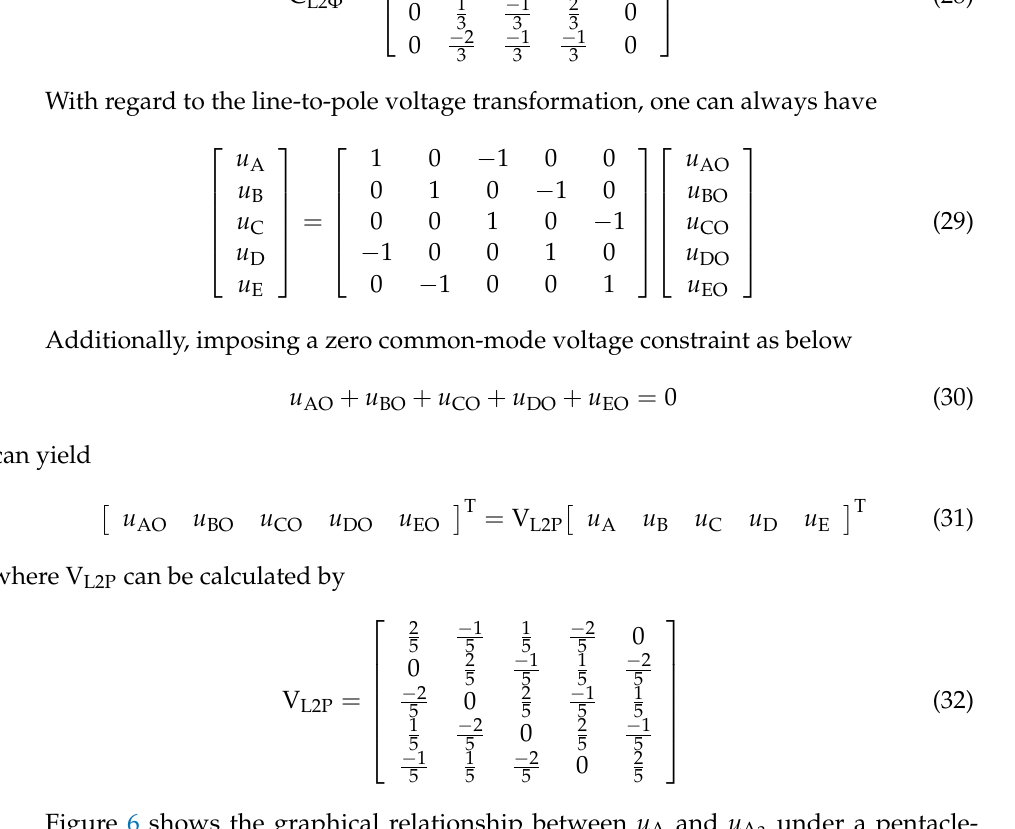
Figure 7. Block diagram of unified open-phase fault-tolerant control for all connection modes.